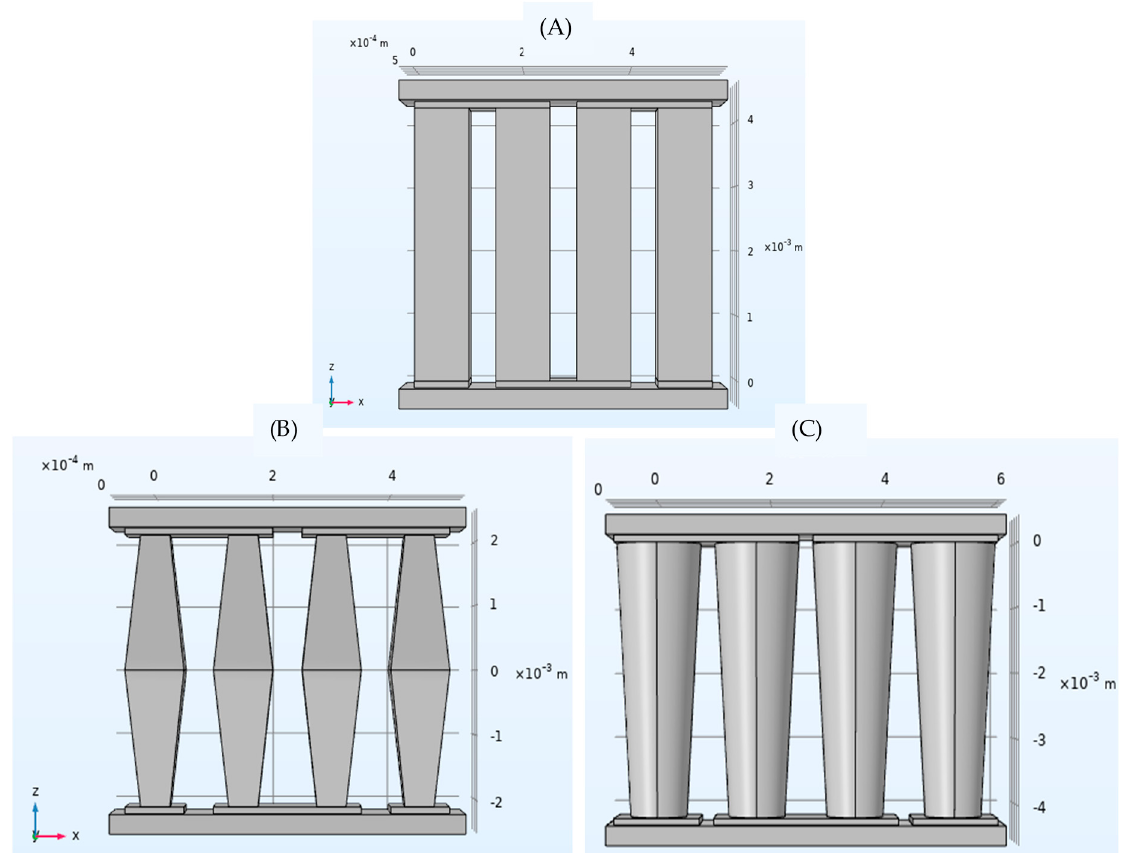
Figure 2. Geometry of the TEG legs analysed: ( A ) Rectangular shape, ( B ) Diamond shape and ( C ) Cone shape. Table 2. TEG model dimensions.